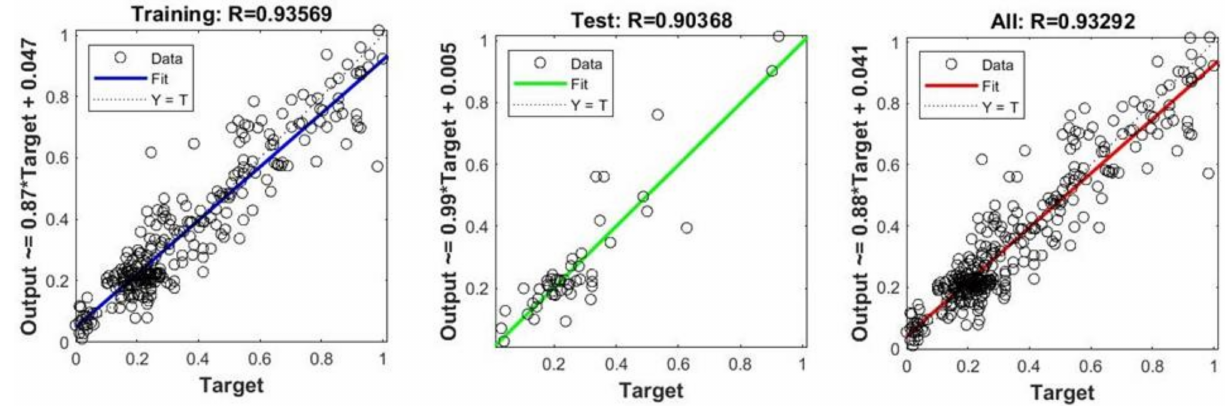
Figure 8. Regression of the output values (given by the model) vs. target (observed values for training, testing and